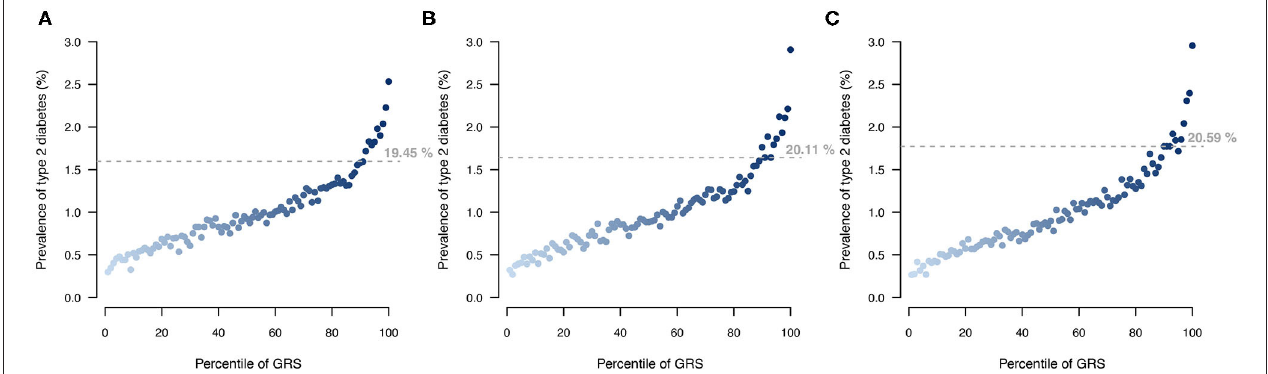
FIGURE 6 | Comparison of T2DM risk gradient within the UKB according to GRS percentile for (A) ST model, (B) MT model using the seven information traits, and (C) MT model with the seven information traits and the T2DM testing data. Each point indicates the average T2DM prevalence within each percentile of GRS across then 10 validation sets. Horizontal lines indicate the prevalence at the top 10 GRS percentile, and percentage indicates the prevalence among the top 10% with the highest genetic